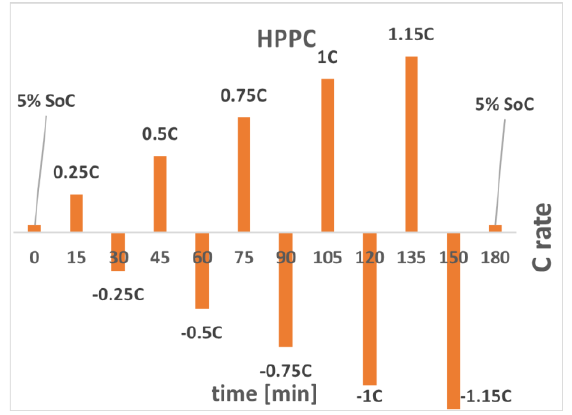
Figure 1. The HPPC testing